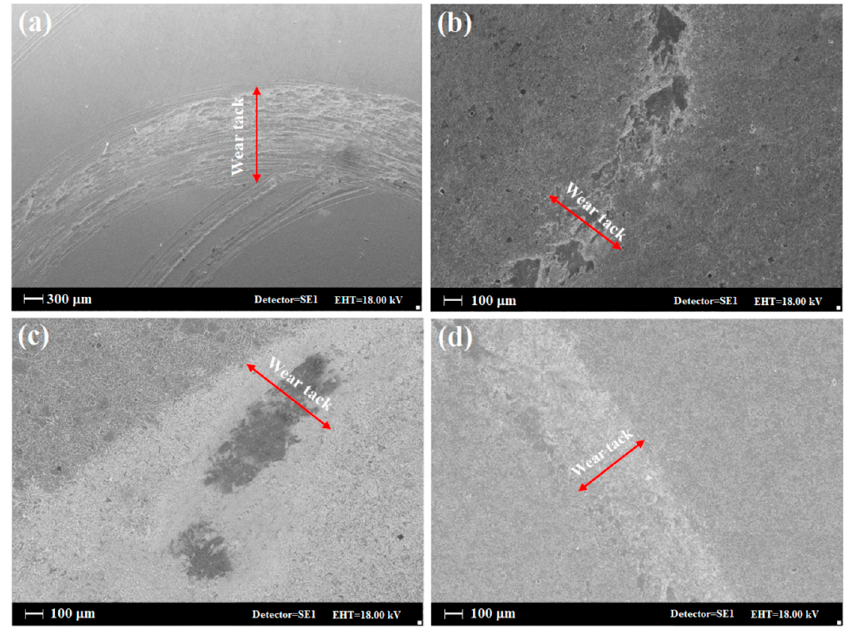
titanium nitride is harder than pins, particles from the pin can be embedded in surface pits associated with a reduction in friction coefficient.